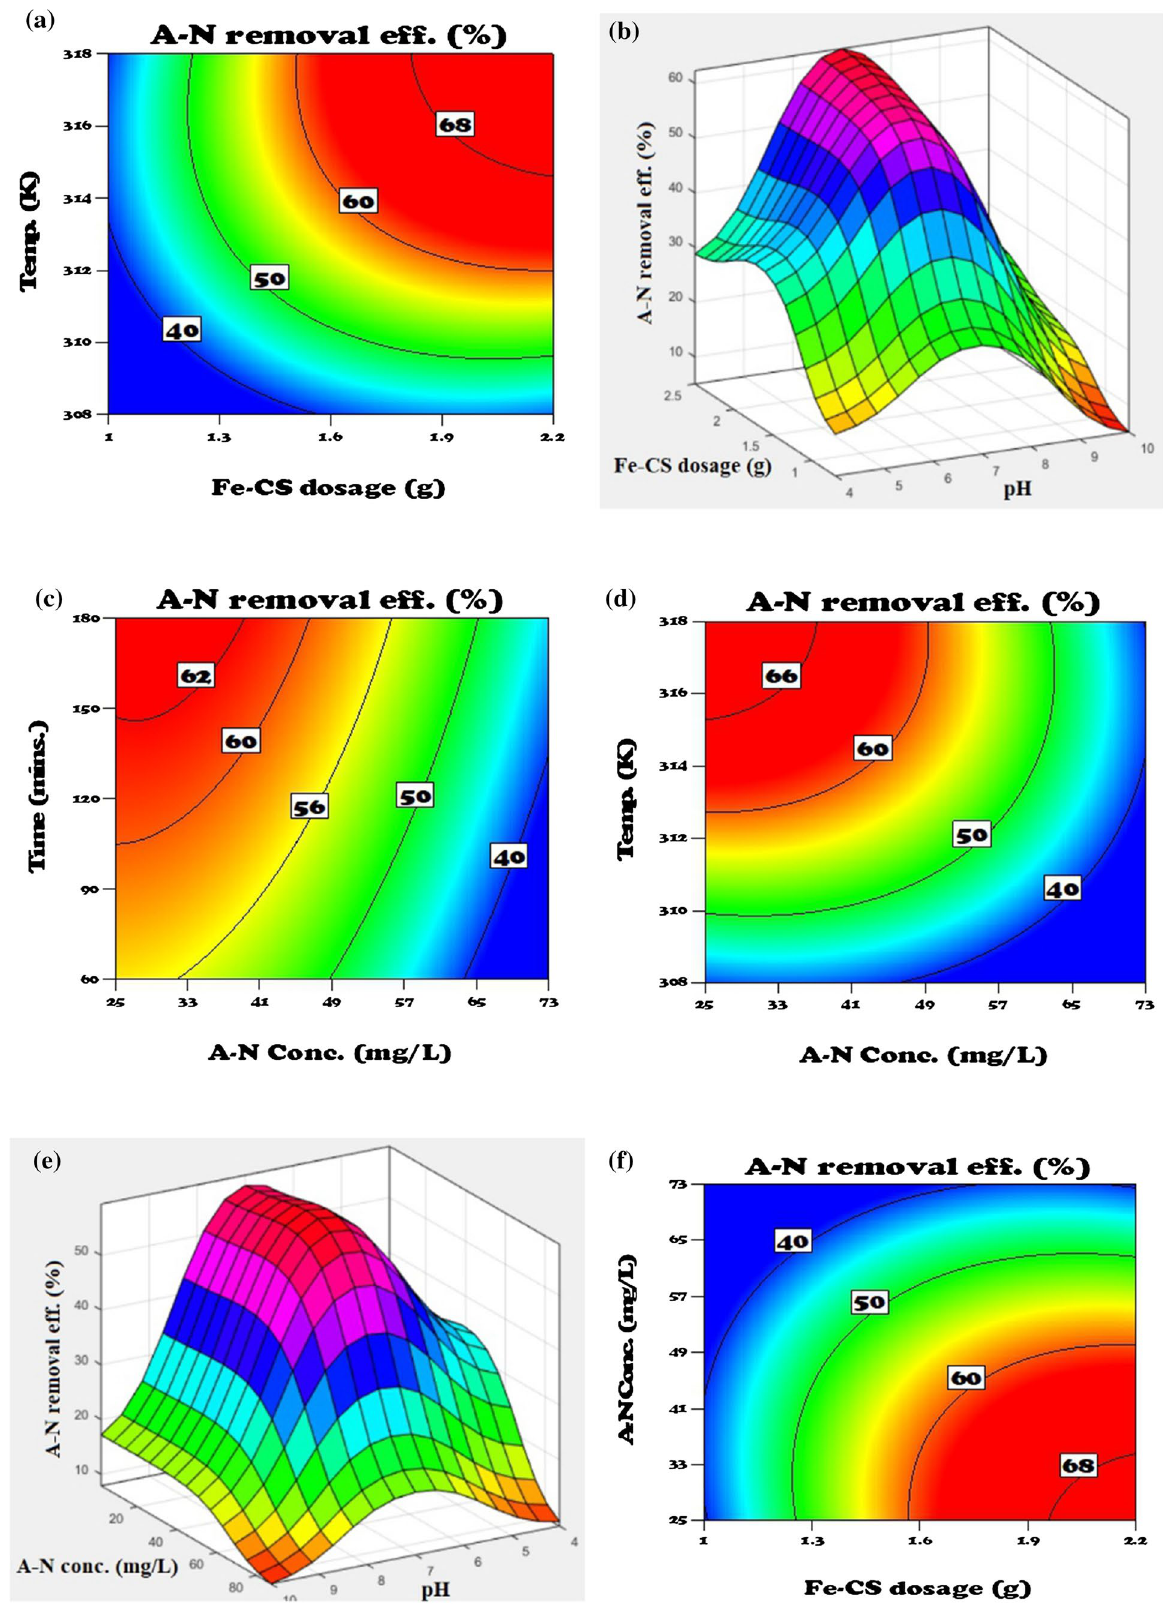
Fig. 7 Surface and contour plots for the adsorption of A–N adsorption onto